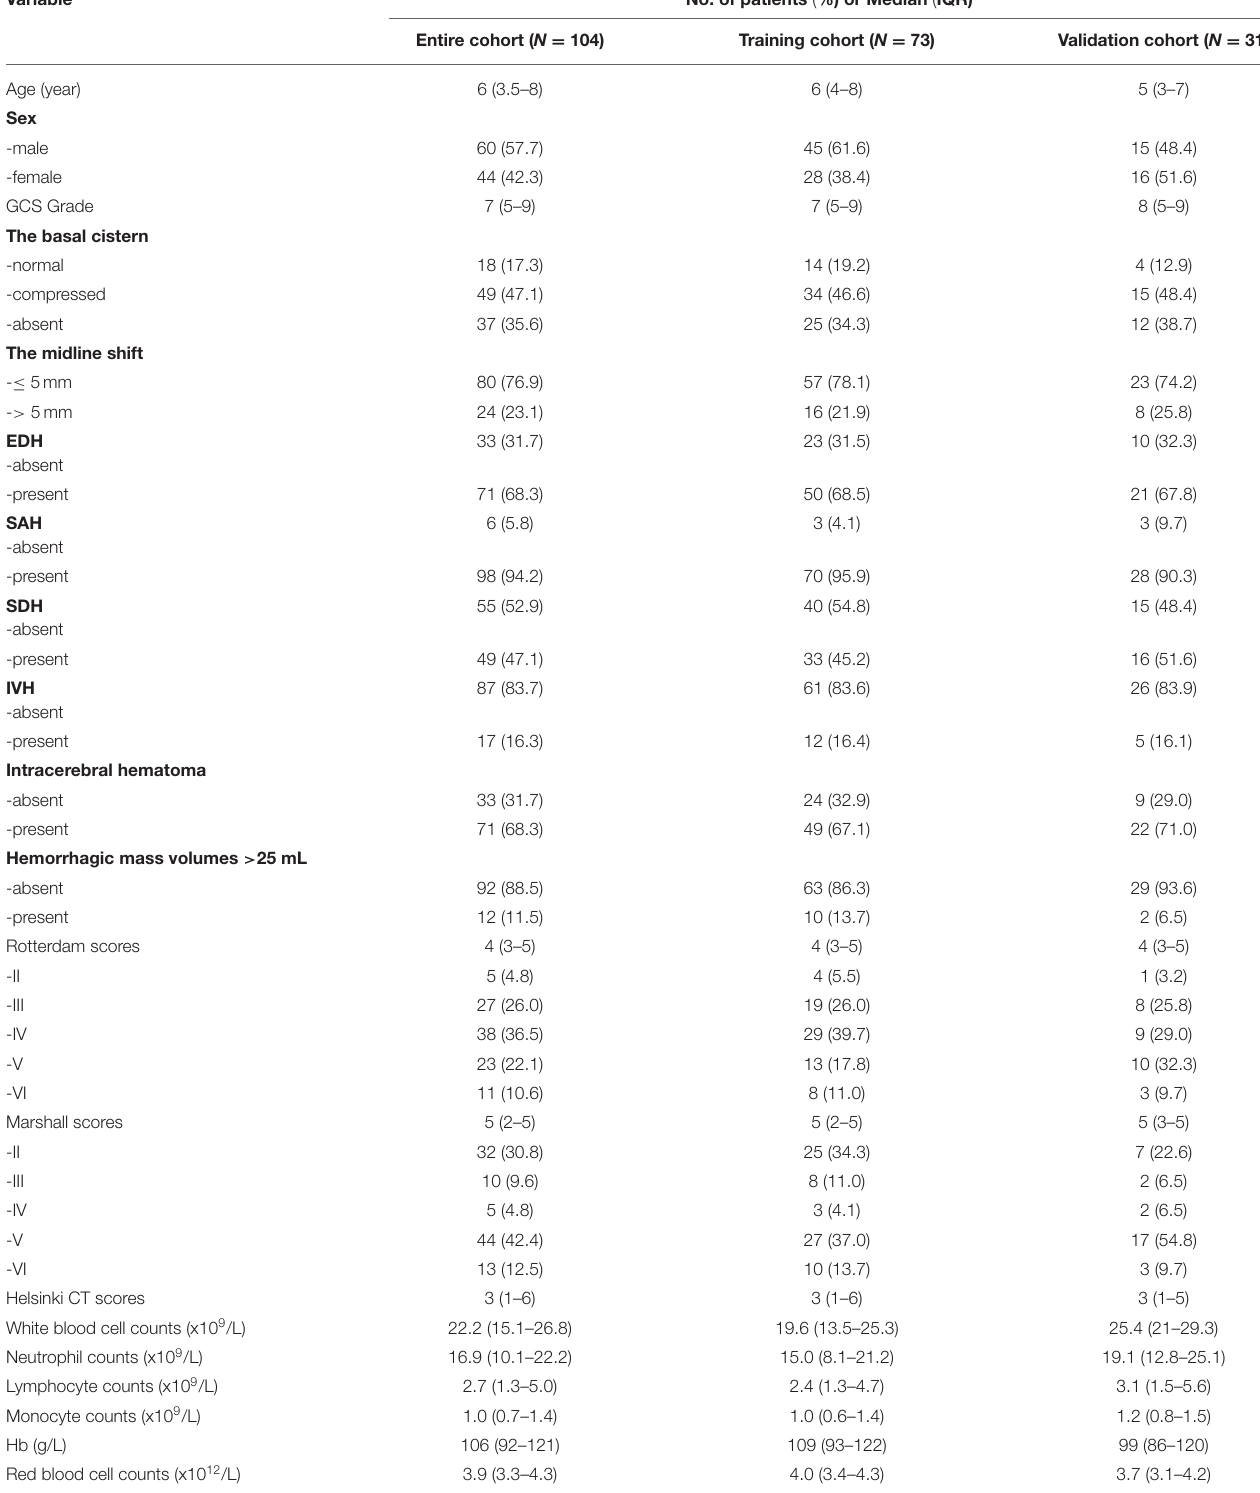
TABLE 1 | Characteristics of the patients in the training and validation cohorts.